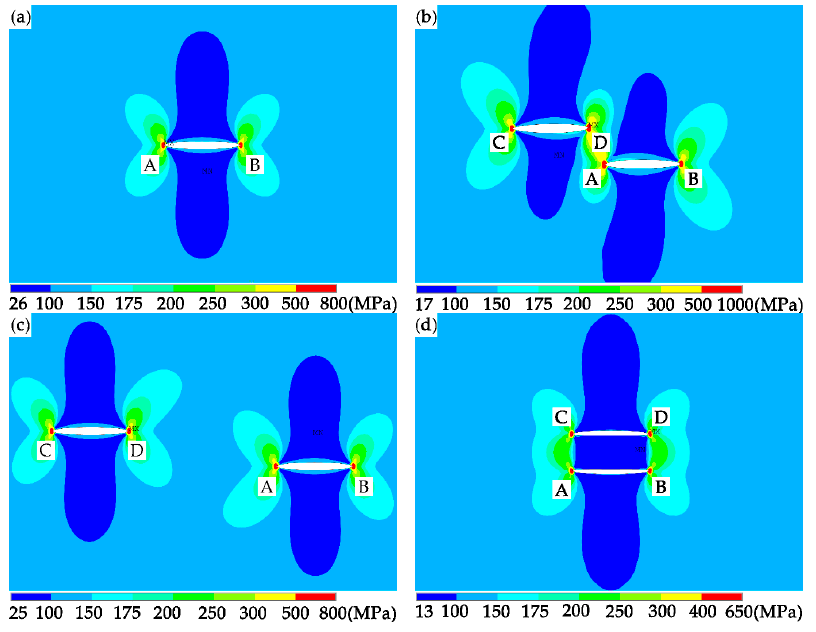
Figure 13. Von Mises stress distributions in the vicinity of the crack tips: ( a ) SC, ( b ) PCS7, ( c ) PCS17, and ( d ) PCS0. Points A-D are the four crack tips shown in Figure